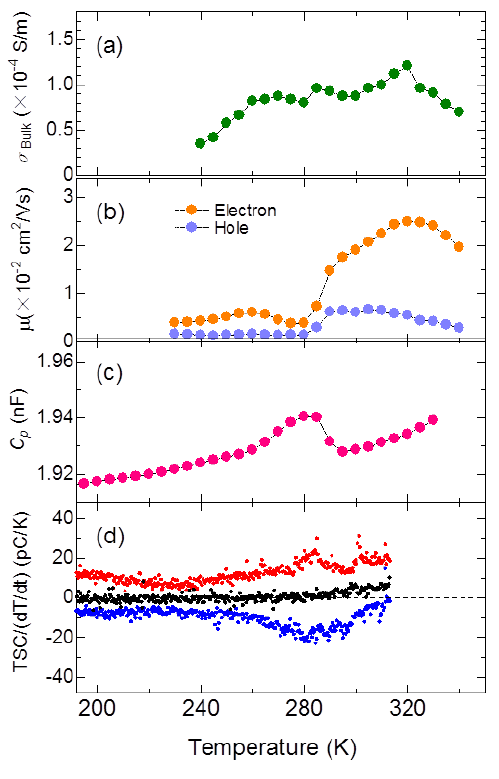
Figure 5. Summary of the physical and electrical parameters observed in the β (cid:48) -(BEDT- TTF)(TCNQ) crystalline FET. Temperature dependence of ( a ) bulk conductance; ( b ) field effect mobility; ( c ) gate capacitance, and ( d )